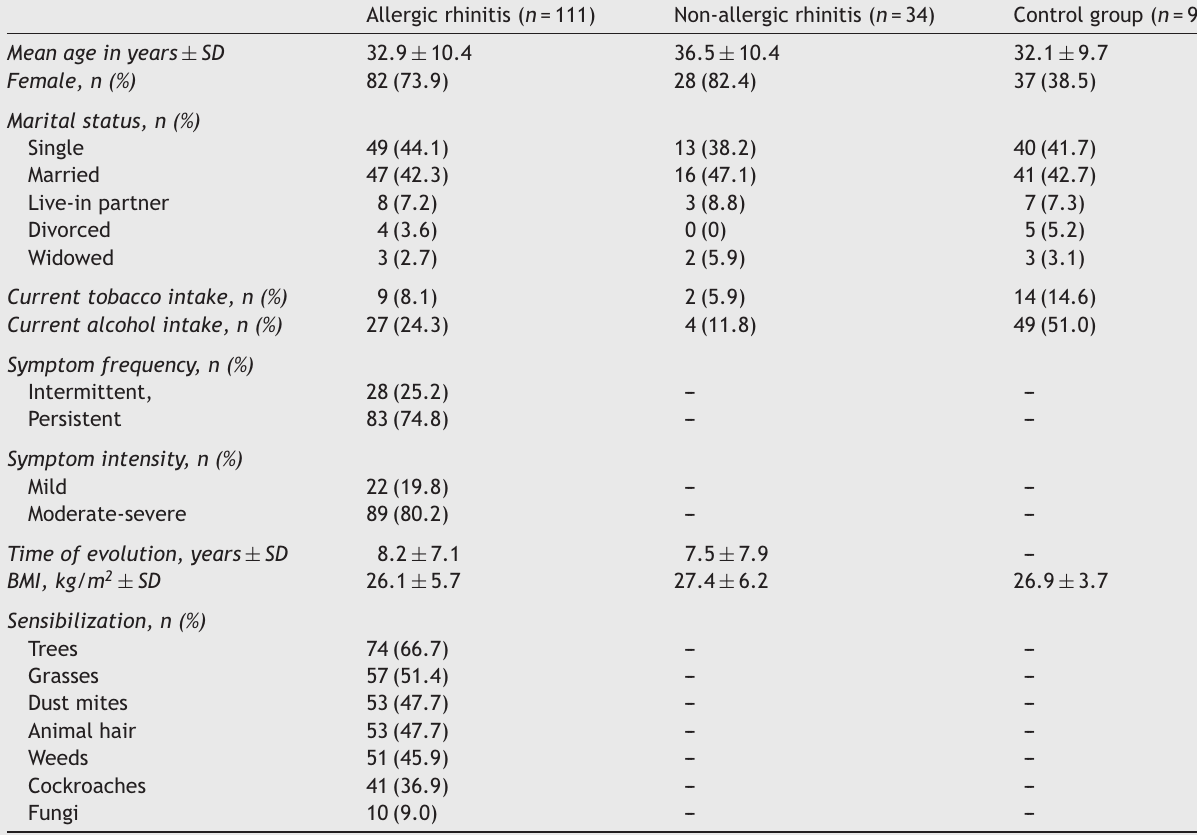
Clinical characteristics of test subjects.